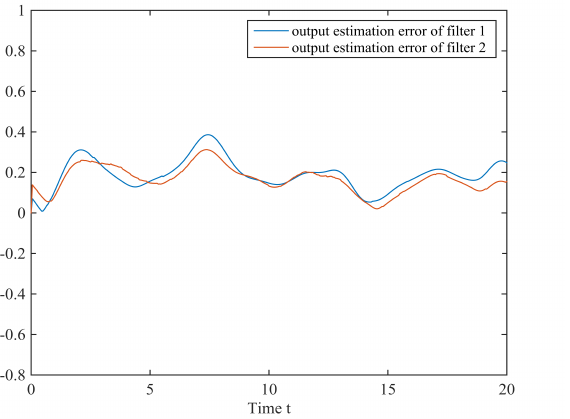
Figure 8. Filter output estimation